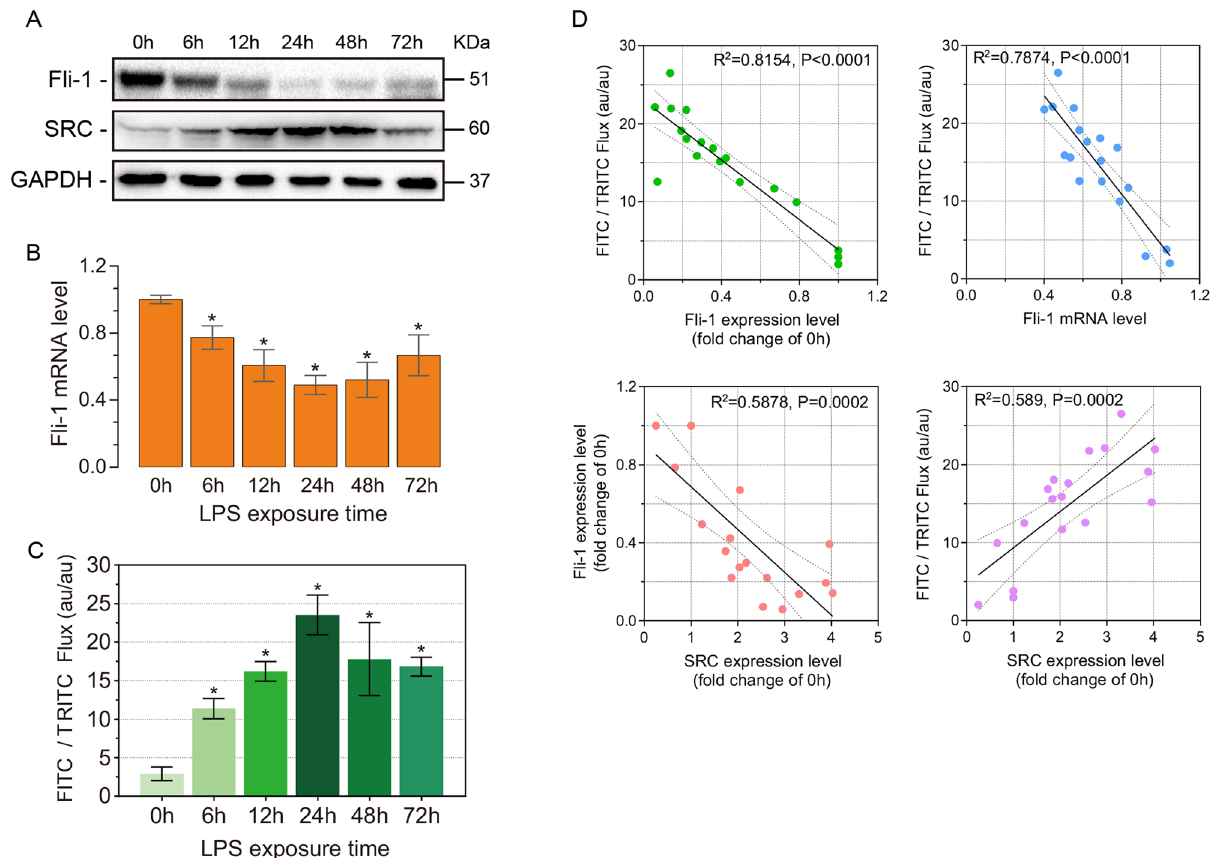
Figure 2. Fli-1 is involved in the process of LPS-induced ALI. ( A ) Fli-1, SRC protein expression levels in lung tissue of mice at 0, 6, 12, 24, 48 and 72 h after LPS treatment (n = 3). Fli-1 original blots are presented in Supplementary Fig. 1. ( B ) Fli-1 mRNA expression level changes (n = 3). ( C ) Dual fluorescent protein tracking assay to detect pulmonary vascular endothelial permeability. ( D ) Pulmonary vascular endothelial